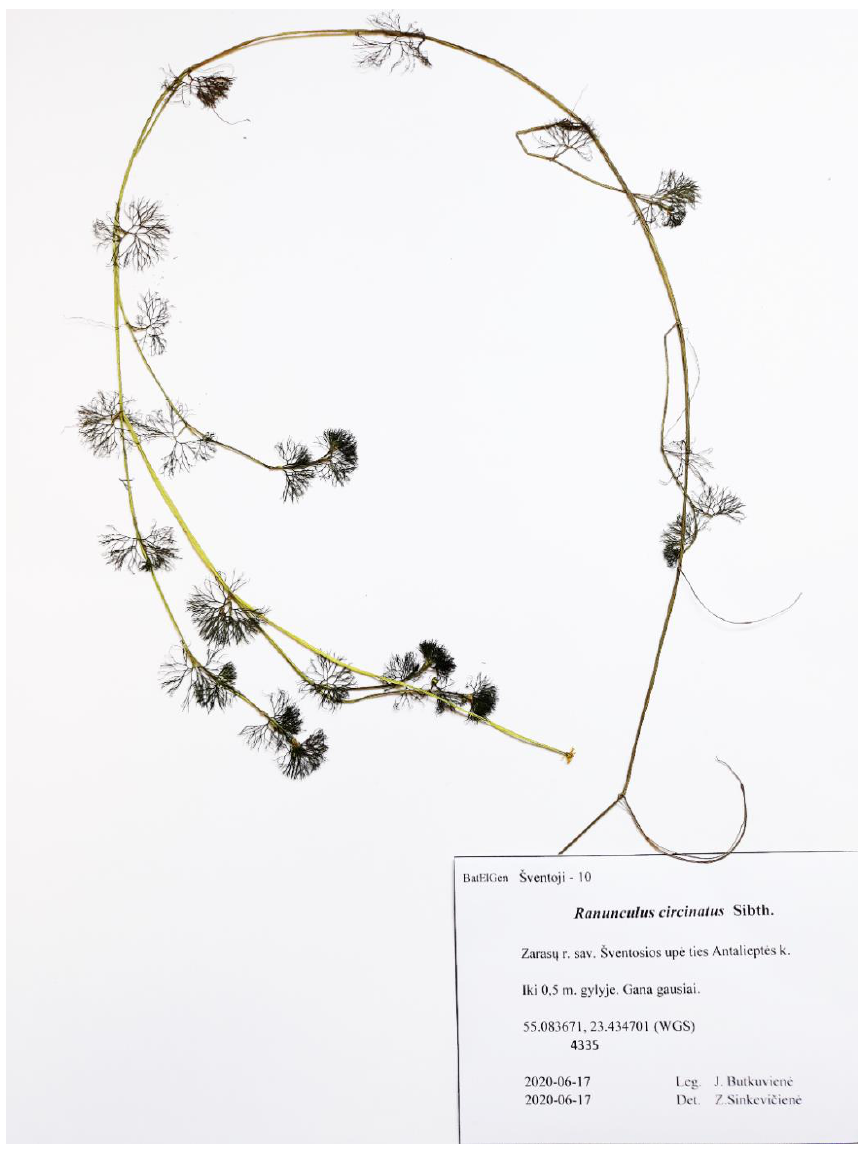
Figure 2. General appearance of Ranunculus circinatus .